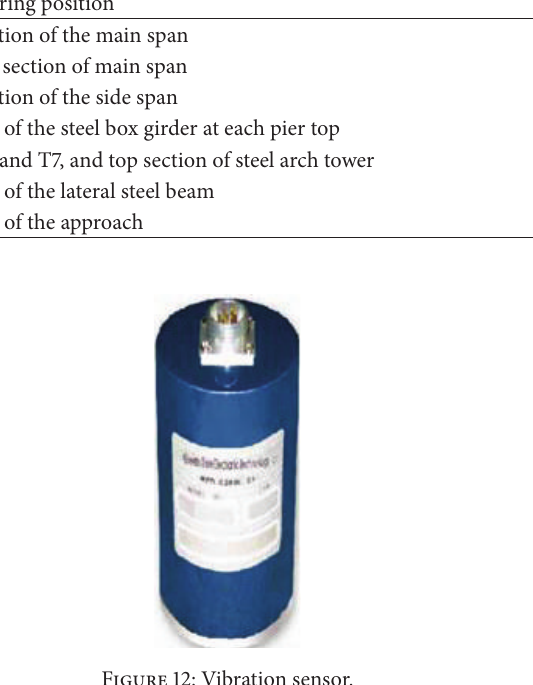
Figure 12: Vibration sensor. Table 9: Layout of the vibration sensors.